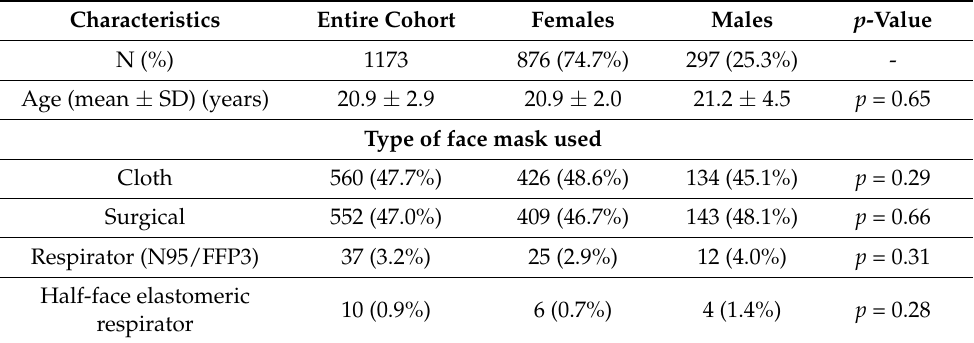
Table 1. The basic results of the entire cohort according to sex. The p -values in bold were considered statistically